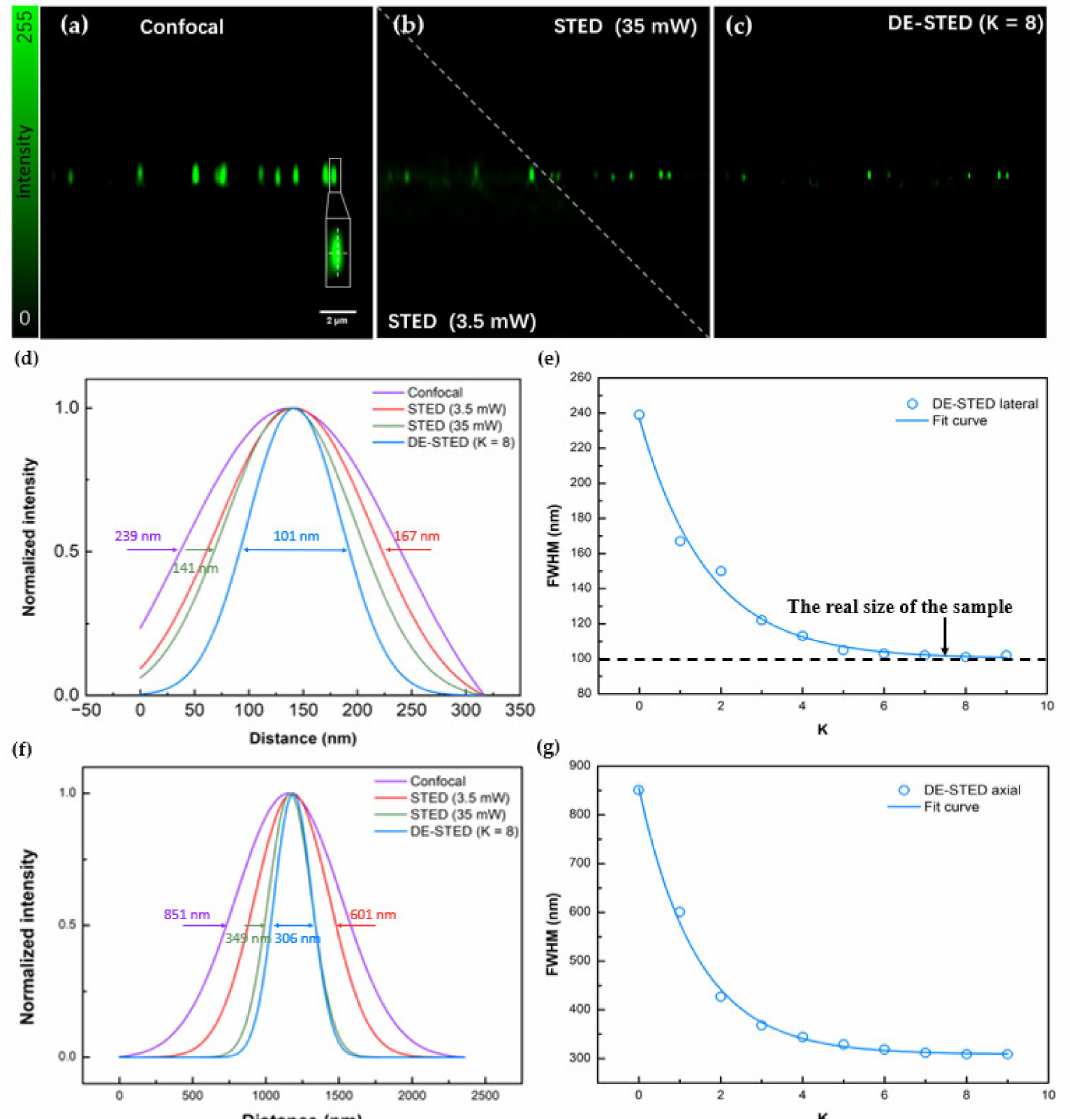
Figure 4. 3D DE-STED imaging results for fluorescent beads on the axial profile. ( a ) Confocal image. ( b ) STED image with depletion powers of 3.5 and 35 mW. ( c ) DE-STED results at K = 8. ( d , f ) Lateral and axial FWHM curves for confocal, STED (3.5 and 35 mW), and K = 8 DE-STED, taking the marked fluorescent beads in ( a ) as the research object. ( e , g ) Curves of the lateral and axial relationship between the FWHM and the K value. Field of view (FOV): 18.03 µ m. Scale bar: 2 µ